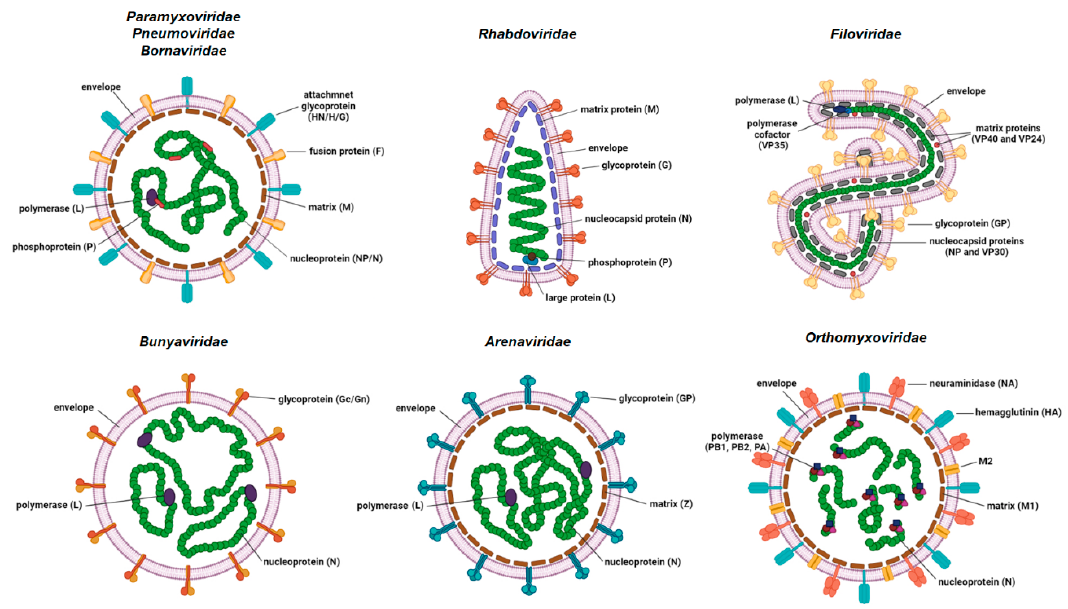
Figure 1. Basic schematic representation of the virion structures of the negative-stranded RNA viruses. Structural proteins are shown. Some genera-specific proteins are omitted from the representation for simplicity (created with BioRender.com, accessed on 21 December 2021).